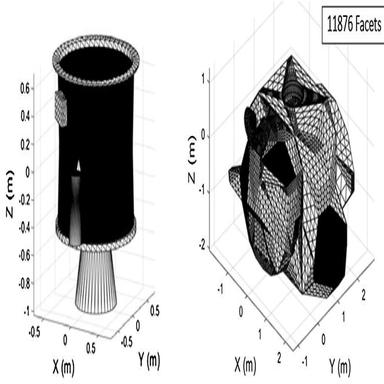
The rendered TLIS (left panel) and Snoopy (right panel) mesh models. A total of 2902 and 11876 facets have been assumed for the two targets, respectively.